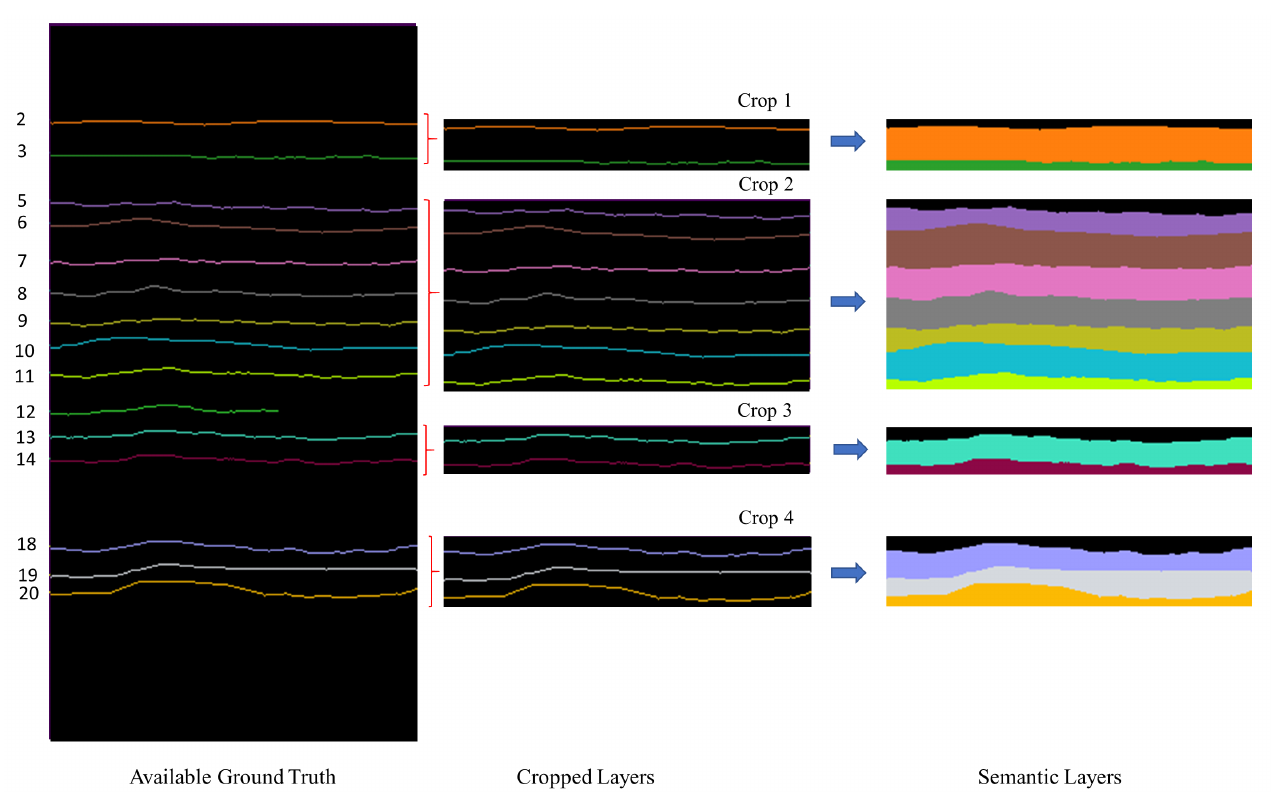
Figure 4. Processing the training labels: We crop out the ‘Available Ground Truth’, into multiple segments, as shown in ‘Cropped Layers’. These cropped portions are then prepared for semantic segmentation, as shown in ’Semantic